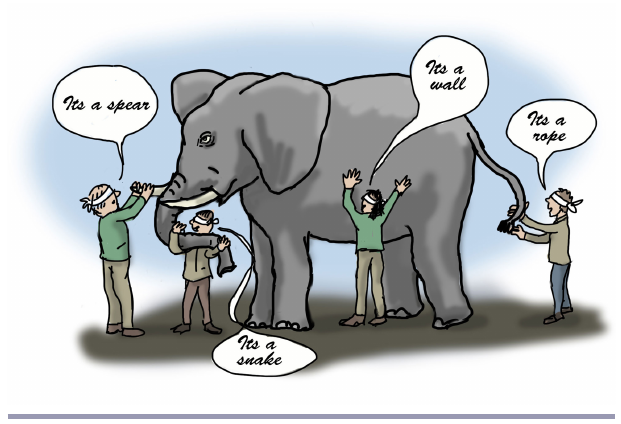
Fig. 5 . The lack of a common analytical framework of social- ecological systems (SES) is a significant challenge for the field of SES to develop and communicate with other social and natural science fields. Artwork by Jonas